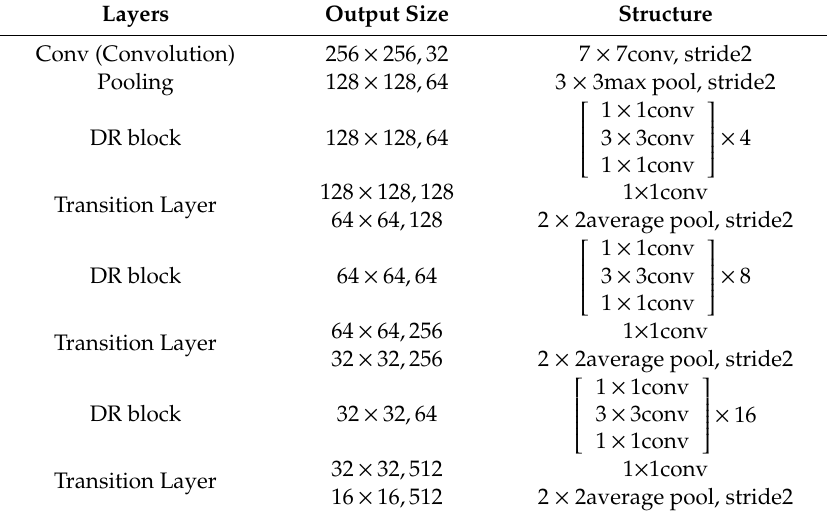
Table 1. DRNet basic